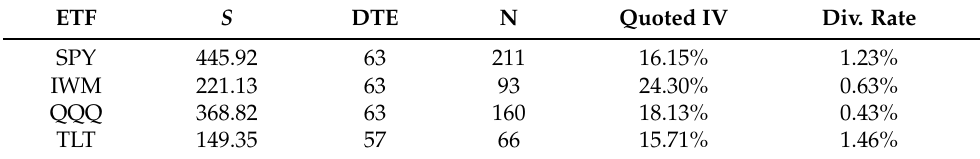
Table 4. Summary information of the four